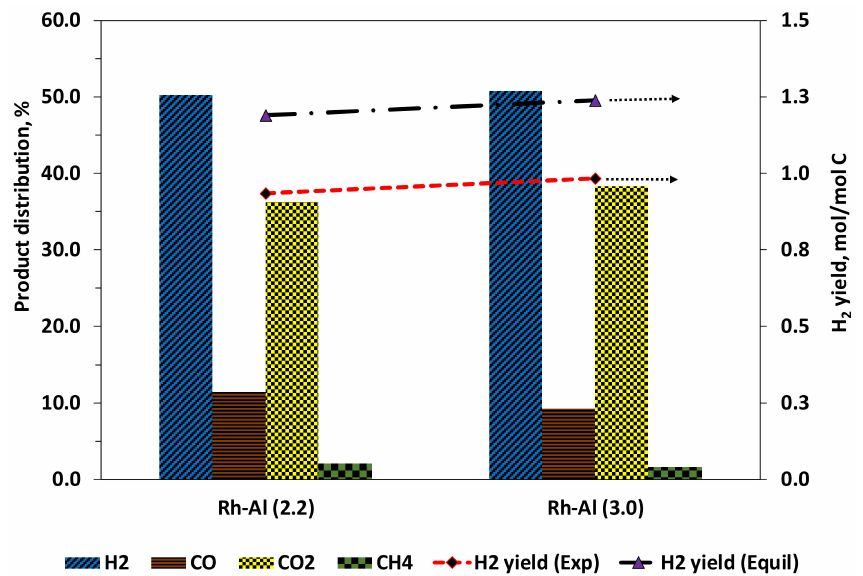
Figure 15. Product distribution for bio-oil surrogate ATR using the Rh-Al catalyst at 1 bar and S/C of 2.2 (with 593 ◦ C and λ = 0.318) and S/C of 3 (with 572 ◦ C and λ = 0.391), respectively.